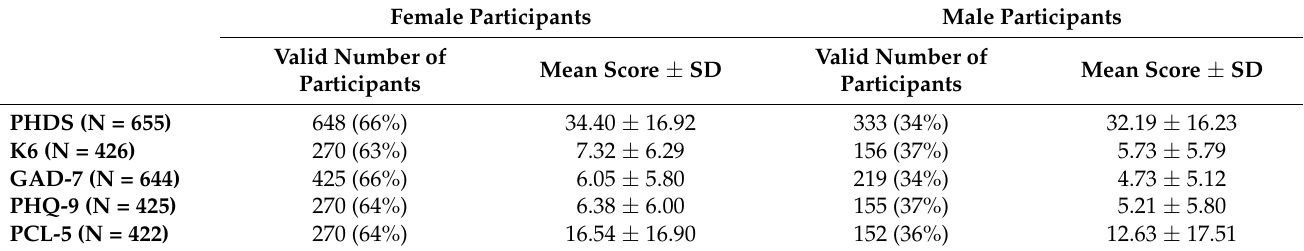
Table 2. Comparison of cumulative PHDS, K6, GAD7, PHQ9, PCL5 scores segregated by